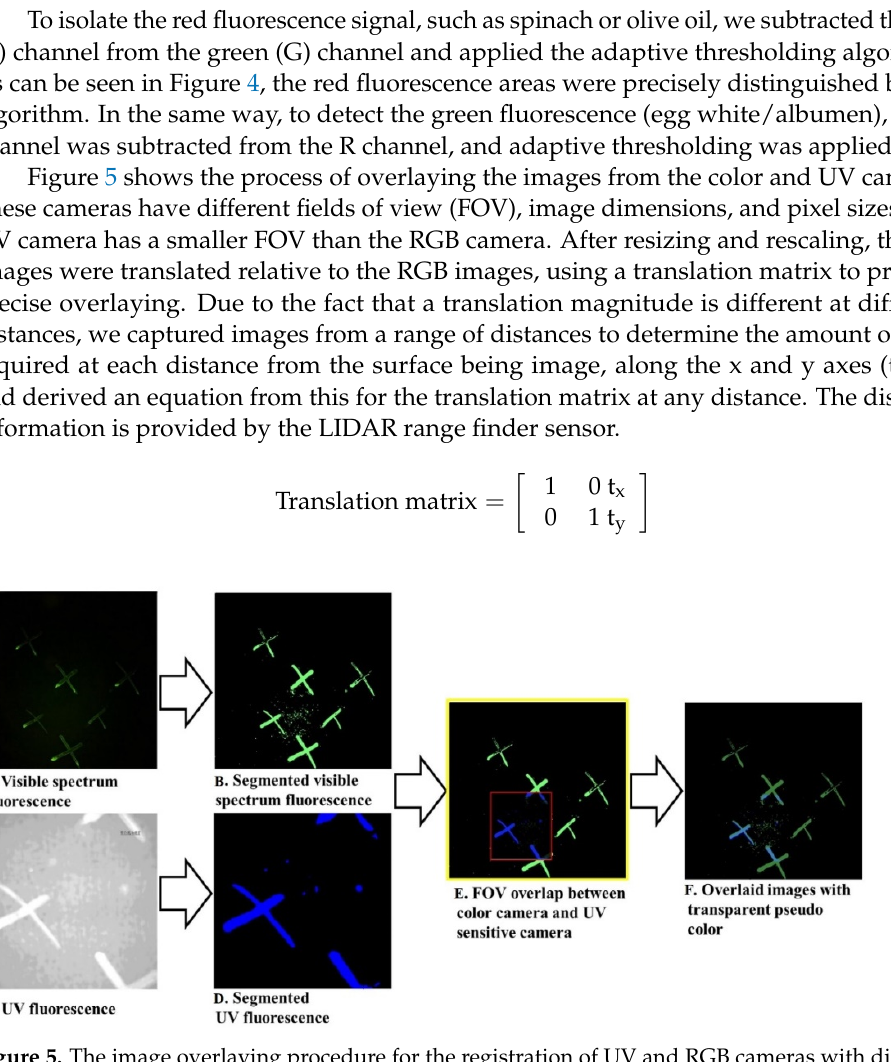
Figure 4. Images from the CSI-D system showing food residues (spinach) on stainless steel (top row) and plastic (bottom row) similar to those described in Figure 3, except the CSI-D RGB camera is used to capture visible light fluorescence instead of the CSI-D UV camera. In this series of images, the red band fluorescence is selected for adaptive thresholding to create the binary image segmentation mask. The scale bar for all images is set to 10 mm.